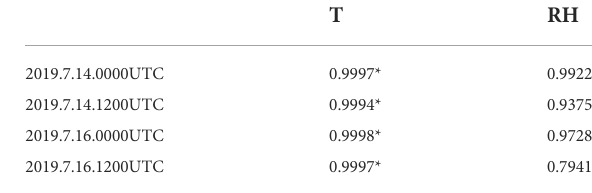
TABLE3Thecorrelationcoef fi cientoftemperatureandhumidity data between microwave radiometer and sounding. (Coef fi cient beyond the 99.9% con fi dence level are denoted by “ * “